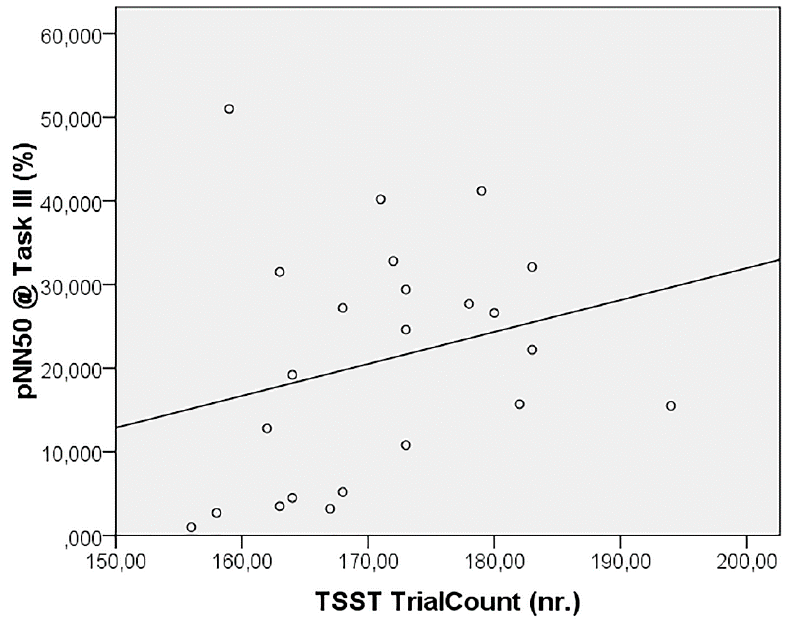
Figure 3. Correlation between TSST trial count and pNN50 during the task.